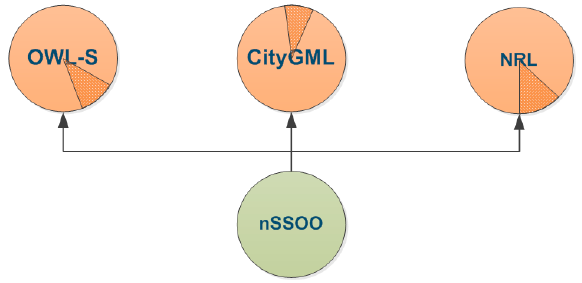
Figure 3. Proposal of nSSOO.